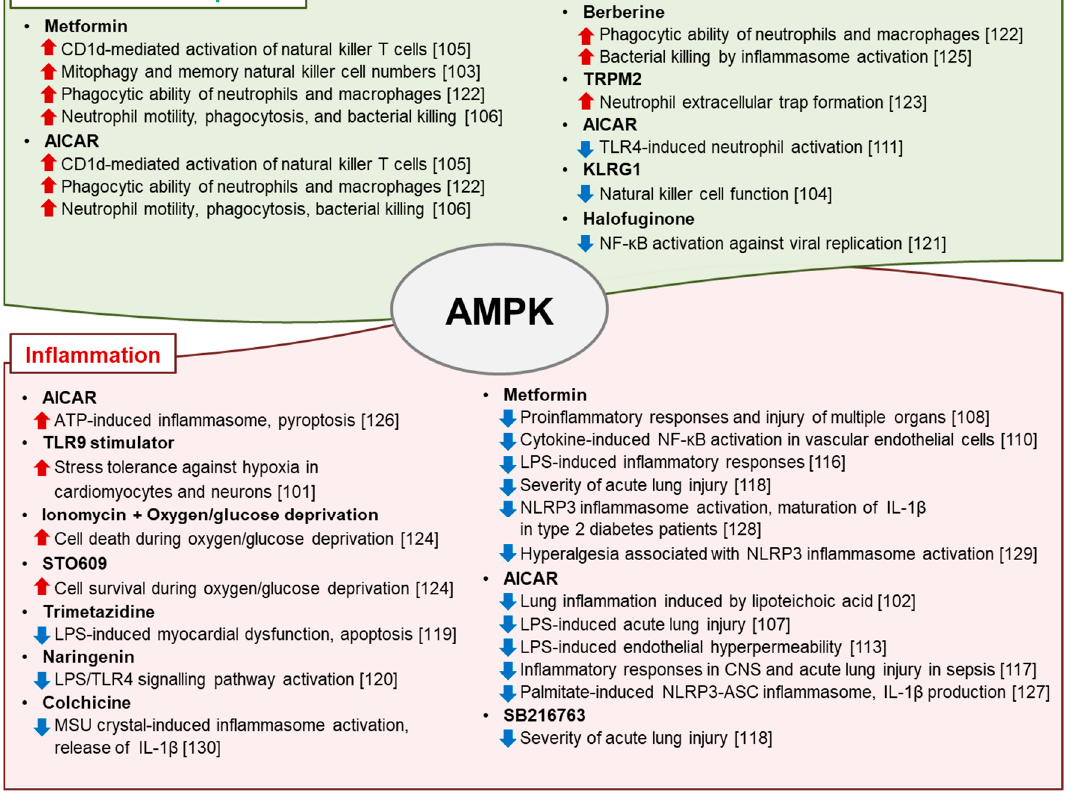
Figure 3. Regulatory effects and underlying mechanisms of small-molecule AMPK activators on the innate immune and inflammatory responses. (red upward arrows indicate activation/increase and blue downward arrows indicate inhibition/decrease)